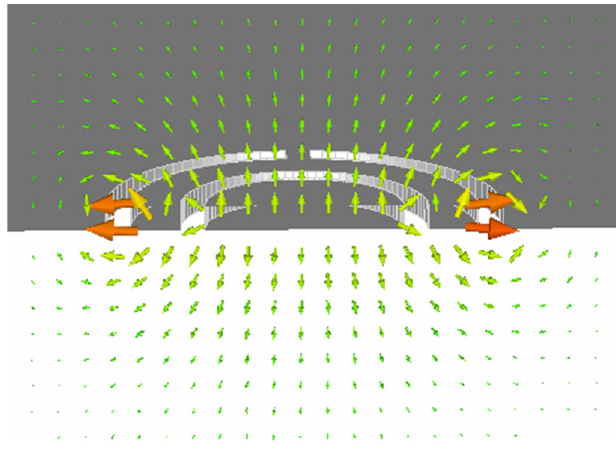
FIG. 6. 2D cut of the CSRR electric field at